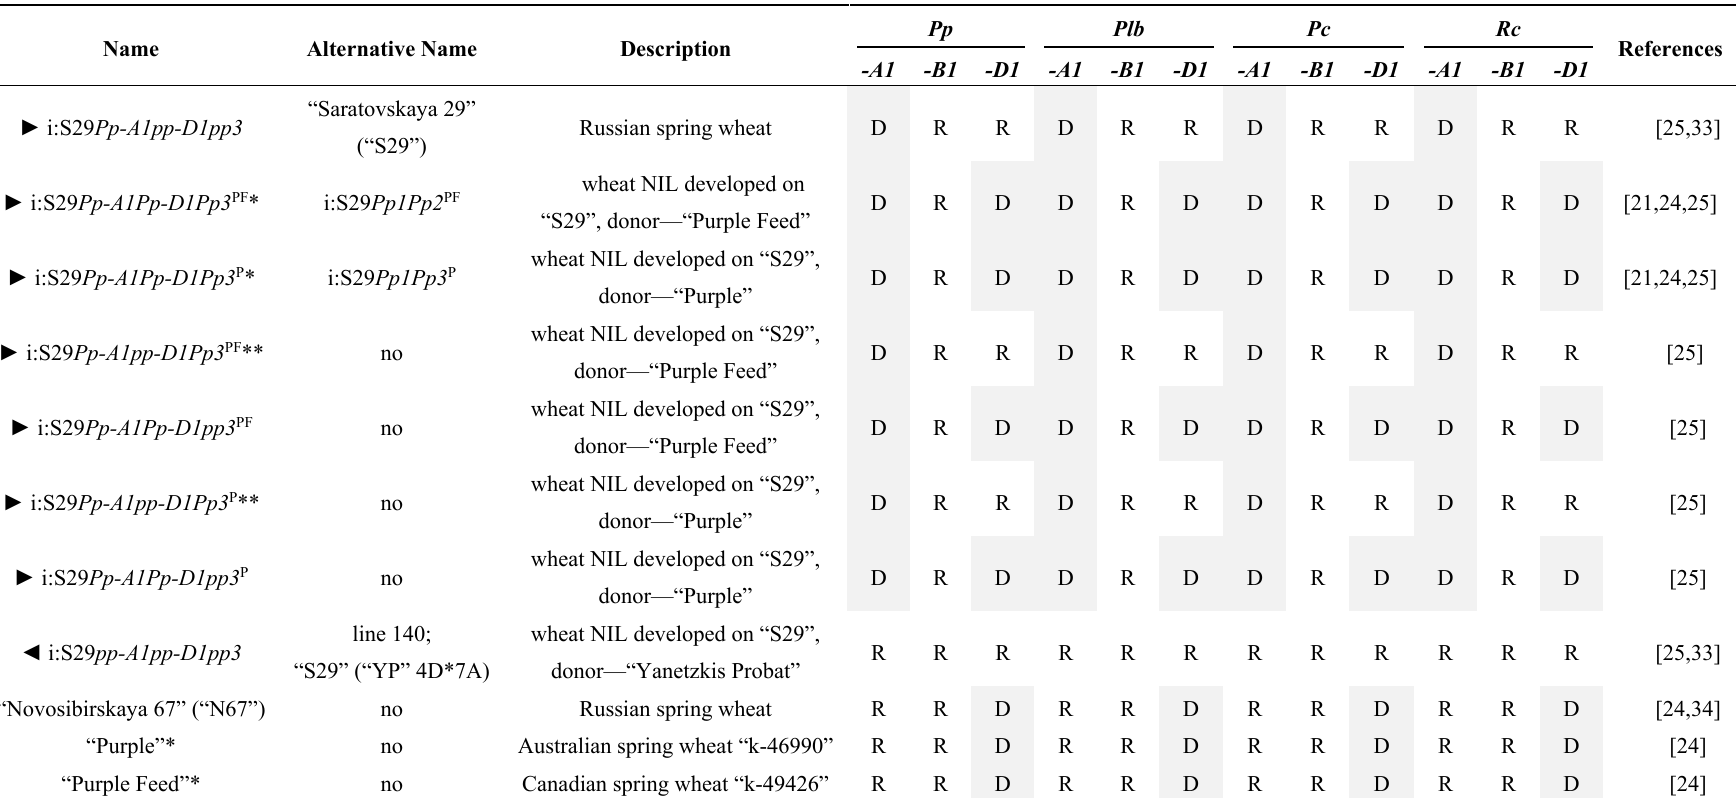
Table 1. Genetic stocks used to characterize the transcription of the Myc -like genes in the wheat grain pericarp (controlled by Pp3 and Pp-1 ), the leaf ( Plb ), the culm ( Pc ) and the coleoptile ( Rc ). D: dominant allele, R: recessive allele, NIL: near-isogenic line, *, **: genotypes, in which the pericarp is, respectively, dark and light purple.